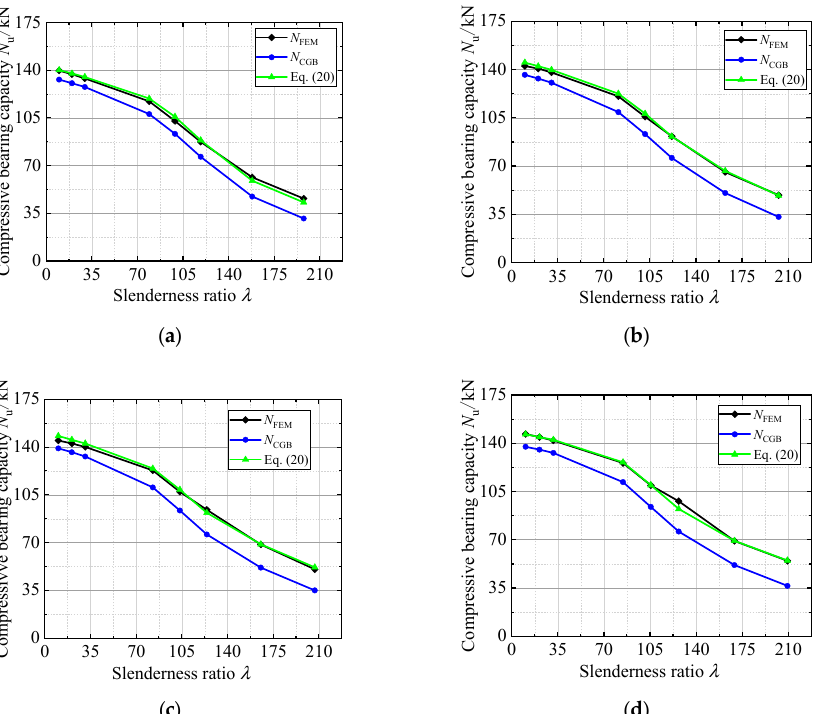
Figure 24. Comparisons of the ultimate compressive bearing capabilities ( a ) C90-40-15-1.5; ( b ) C120- 40-15-1.5; ( c ) C140-40-15-1.5; ( d ) C160-40-15-1.5.